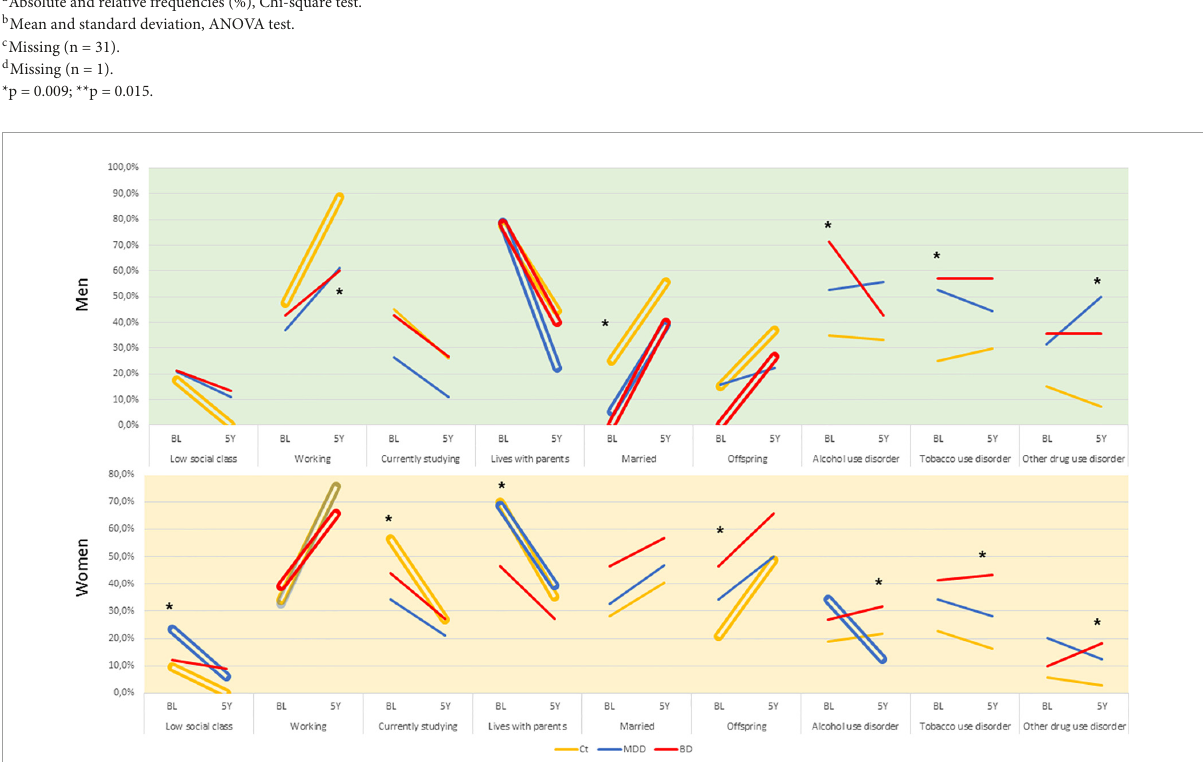
FIGURE1 Changes in socioeconomic variables and substance abuse/dependence according sex at baseline and 5-year follow-up in emerging adults with and without mood disorders. Double bars indicate significant within-group changes ( p < 0.05) and asterisks indicate significant between-group changes ( p <